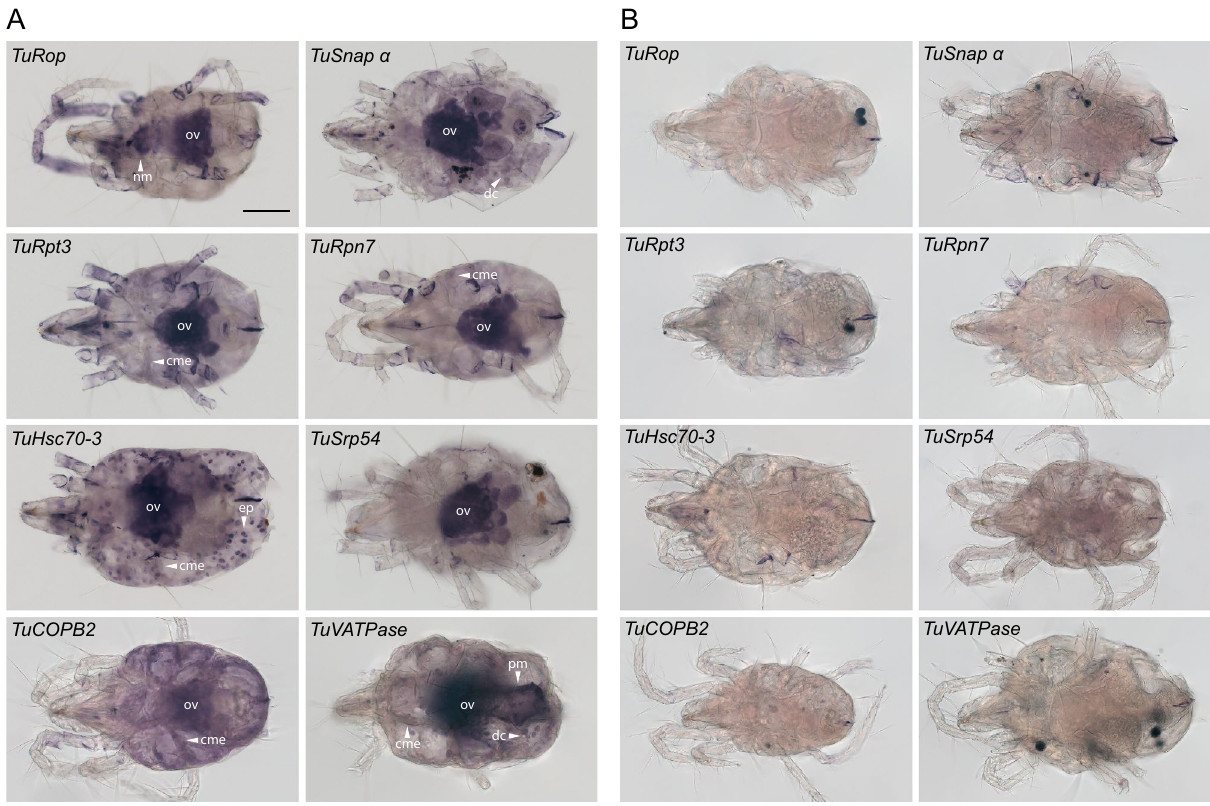
Figure 4. Whole-mount in situ hybridization of TuRop, TuSnap α , TuRpt3 , TuRpn7, TuHsc70-3, TuSrp54, TuCOPB2 and TuVATPase in adult T. urticae females. Anti-sense ( A ) and sense ( B ) digoxigenin-labeled